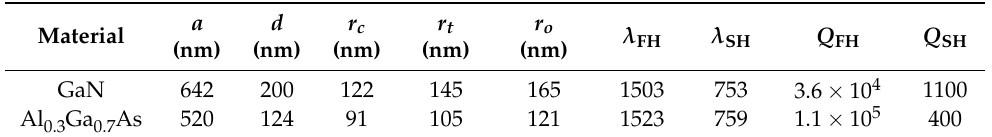
Table 2. Main design parameters of the GaN and Al 0.3 Ga 0.7 As cavities, and the related doubly- resonant features obtained from 3D FDTD